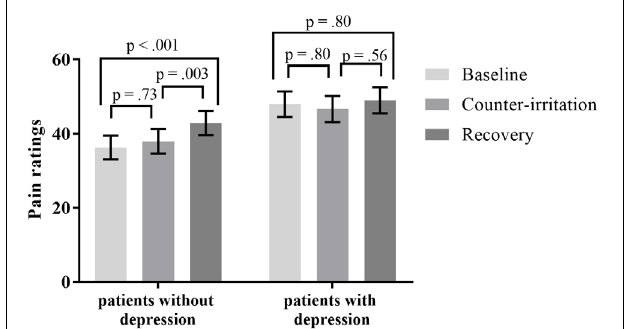
FIGURE 2 | Least square mean pain ratings for electrocutaneous stimuli for patients with and without comorbid depression, in the baseline, counter-irritation, and recovery phase. Depression was diagnosed by the MINI International Neuropsychiatric Interview 5.0.0. p -values are corrected for multiple testing with the stepdown Bonferroni method. Vertical bars denote standard